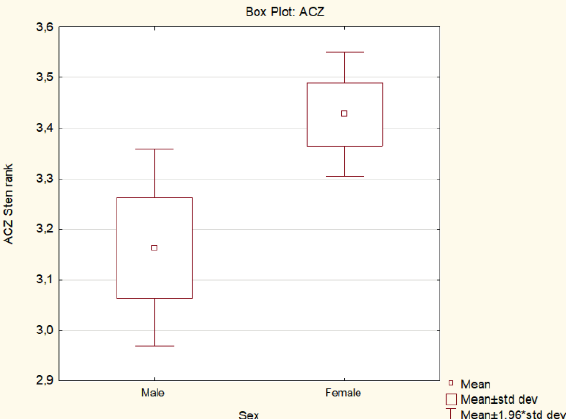
Figure 4. The differences of engaging in replacement activities rank between sexes. Box Plot.